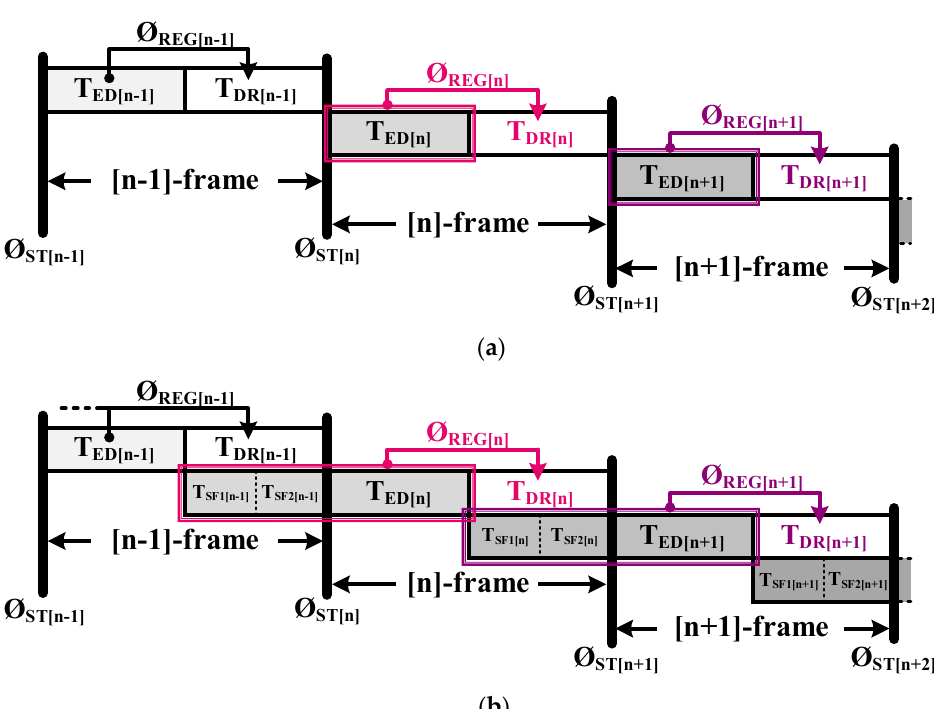
Figure 4. Data readout timing of ( a ) a conventional and ( b ) the proposed LADAR receiver.